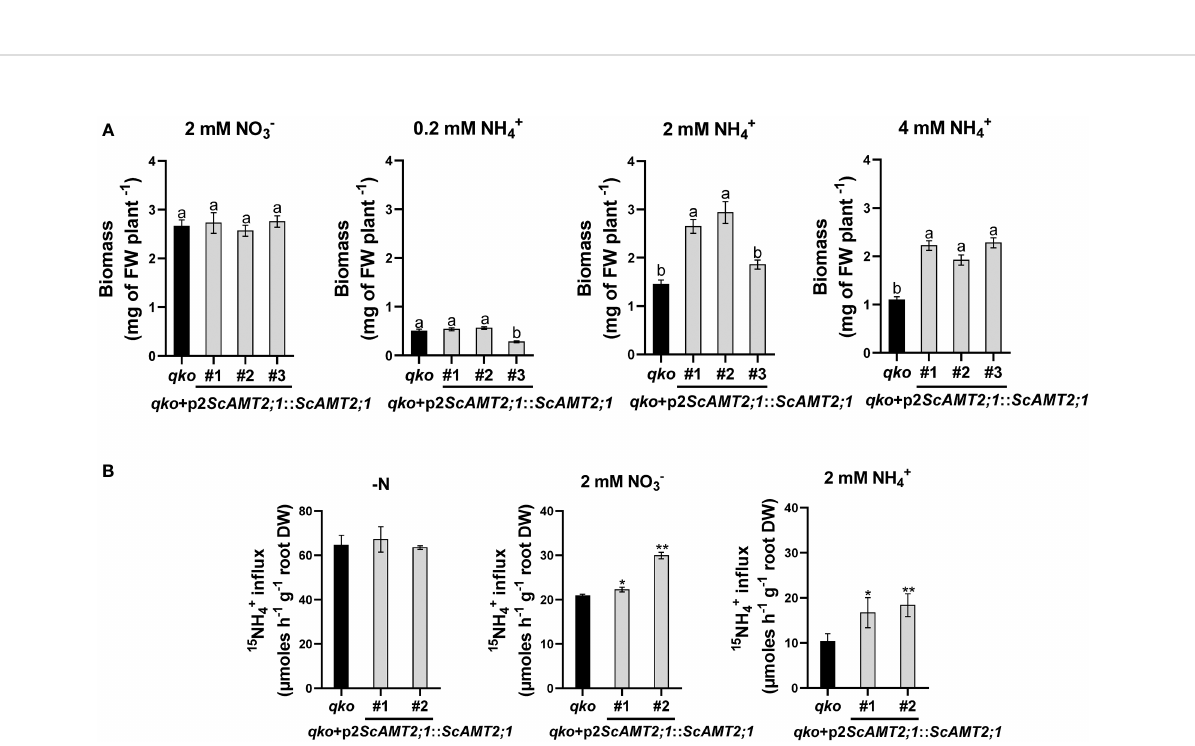
FIGURE 6 Biomass accumulation in Arabidopsis mutant plants and lines complemented with ScAMT2;1 driven by the sugarcane endogenous promoter. (A) Fresh weight of homozygous lines of qko +p2 ScAMT2;1 :: ScAMT2;1 subjected to 2 mM KNO 3 (NO3-) or 0.2, 2, and 4 mM NH 4 Cl (NH 4+ ) for 14 d. Bars indicate means ± SE ( n = 30). Different letters indicate signi fi cant differences among means according to Tukey ’ s test ( p ≤ 0.05). (B) In fl ux of 15 N-labeled ammonium (NH 4 + ) into roots of qko and qko +p2 ScAMT2;1 :: ScAMT2;1 lines upon 3-d exposure to N-free (-N), 2 mM NO3-, or 2 mM NH 4+ nutrient solution. Bars indicate means ± SE ( n = 4). Asterisks indicate signi fi cant differences between qko and transgenic plants according to Student ’ s t test (* p < 0.10 and ** p <